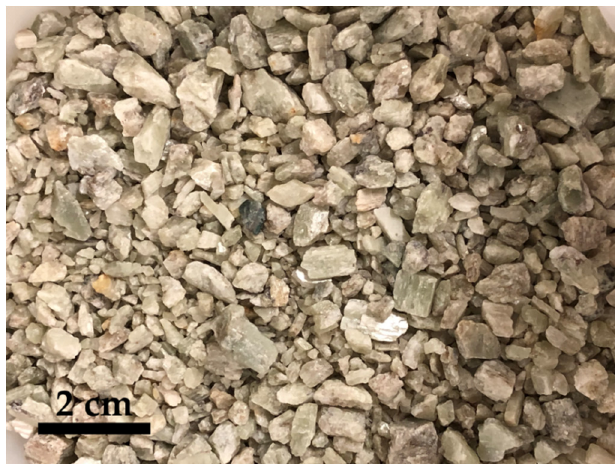
Figure 1. Spodumene concentrate used for the experiments.